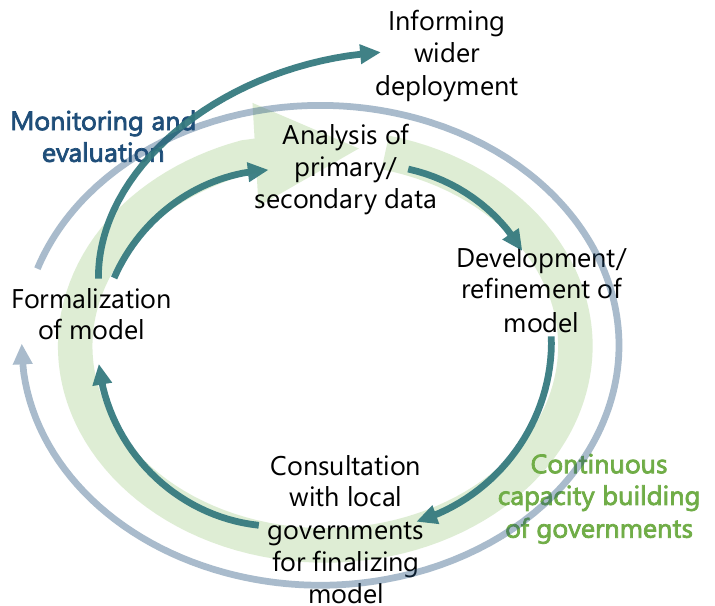
Figure 9. Proposed process cycle adopted for evolving the most contextually apt model for intergov- ernmental urban–rural